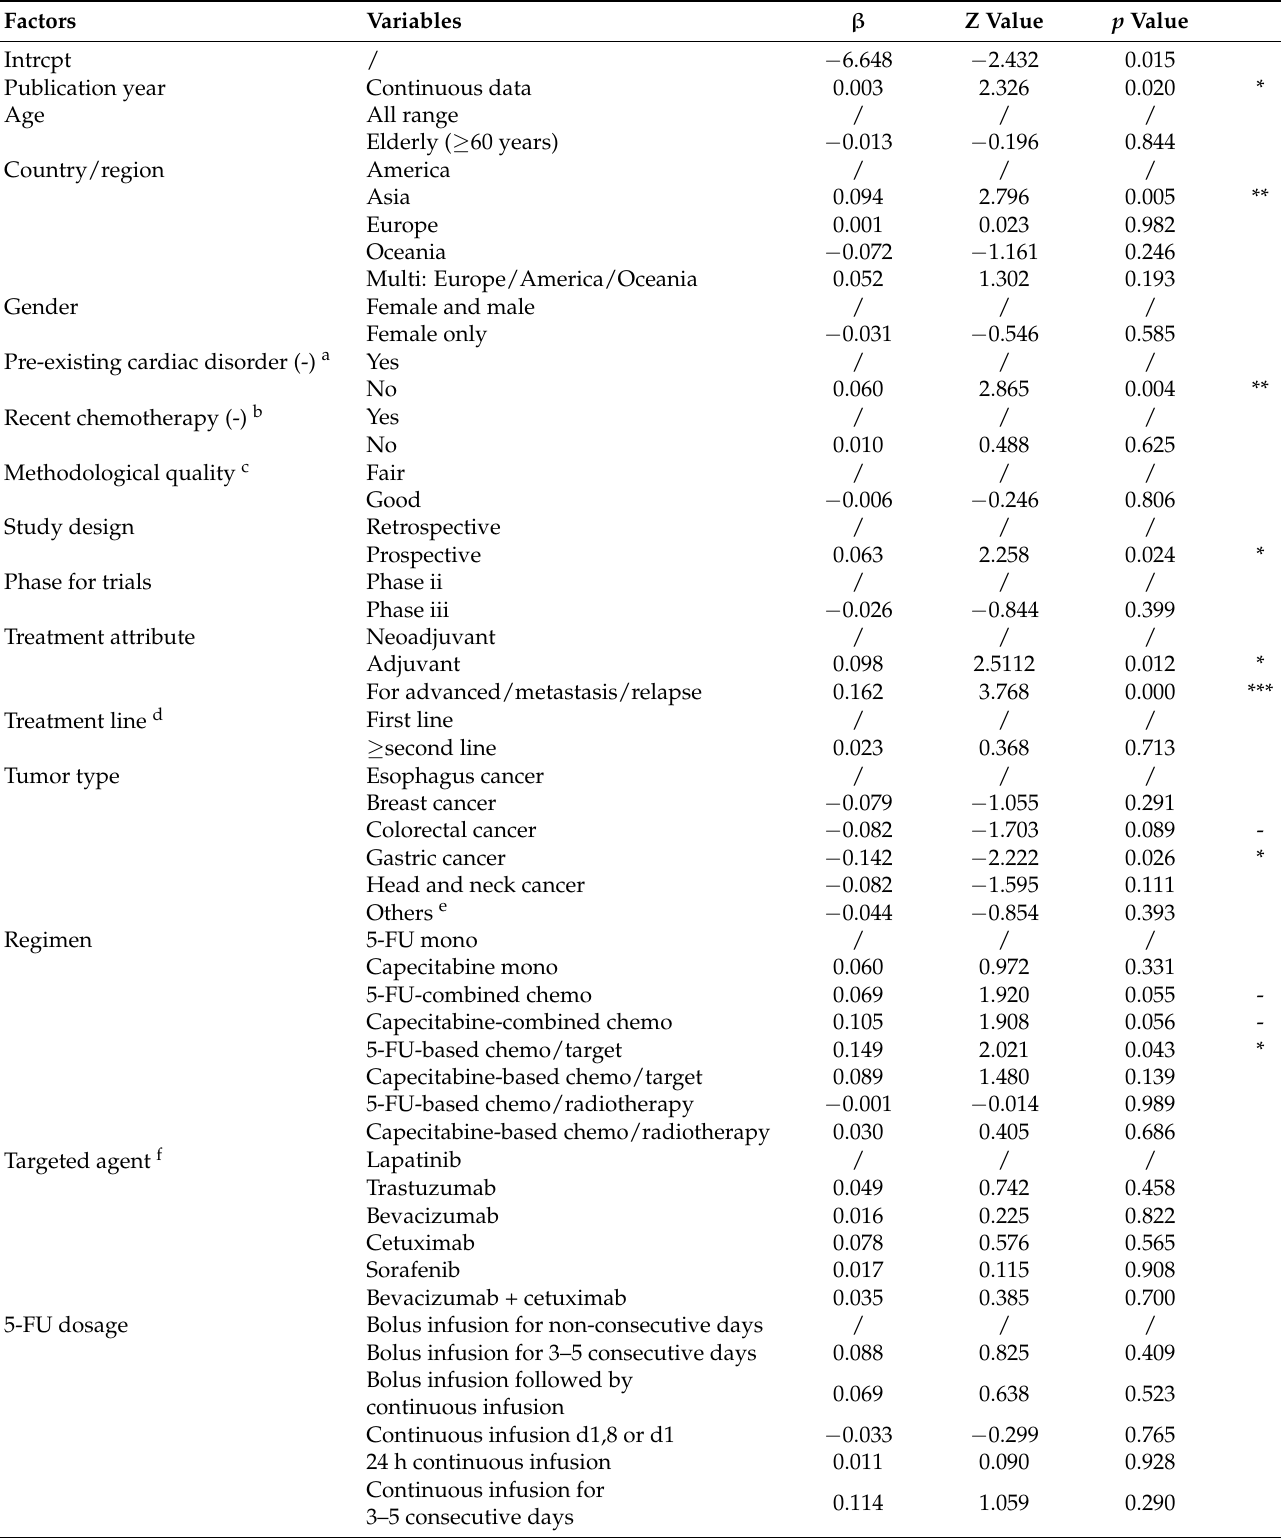
Table 3. The results of multilevel meta-regression